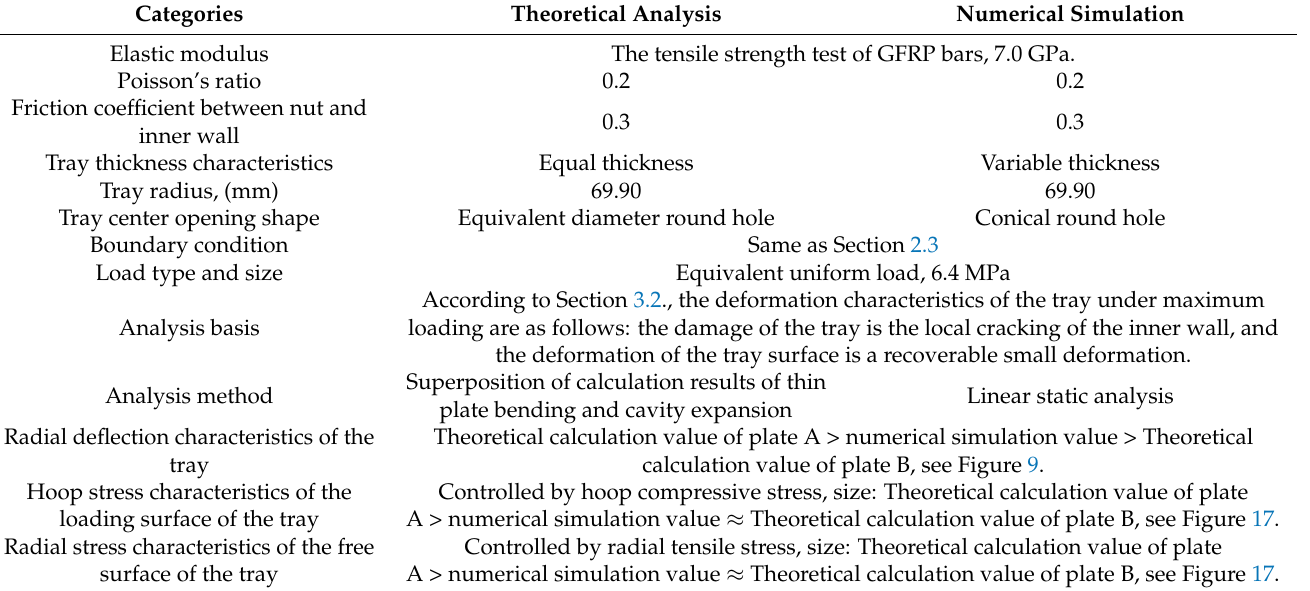
Table 3. Comparisons of theoretical analysis and numerical simulation.